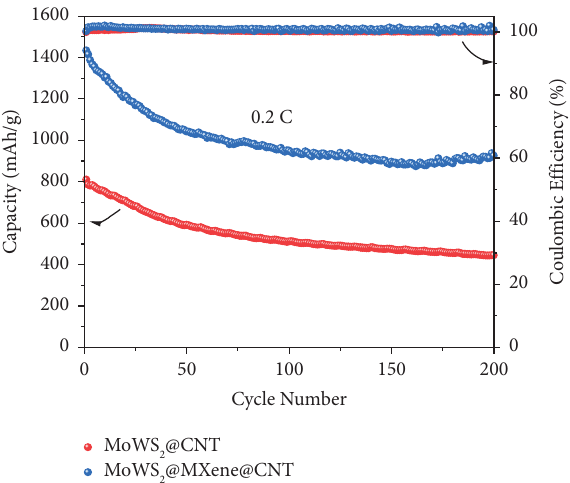
Figure 8: Cycle performance of the MoWS 2 @MXene@CNT/S and MoWS 2 @CNT/S cathodes for 200 cycles at 0.2